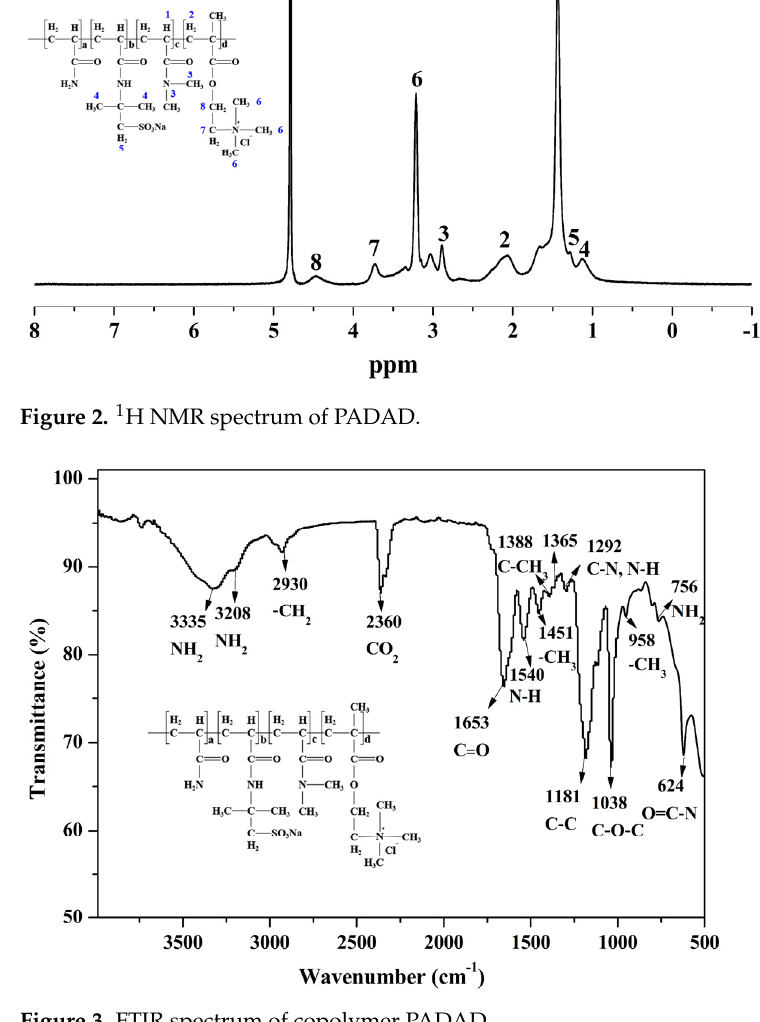
Figure 3. FTIR spectrum of copolymer PADAD.